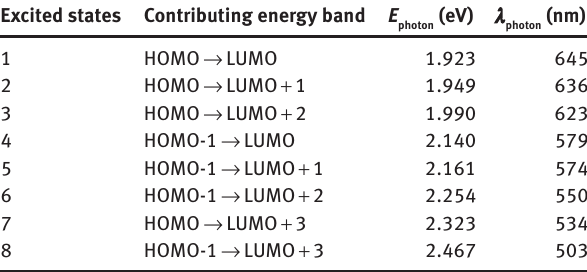
Table 1: The TD-DFT derived electron transitions and their respective excited states.